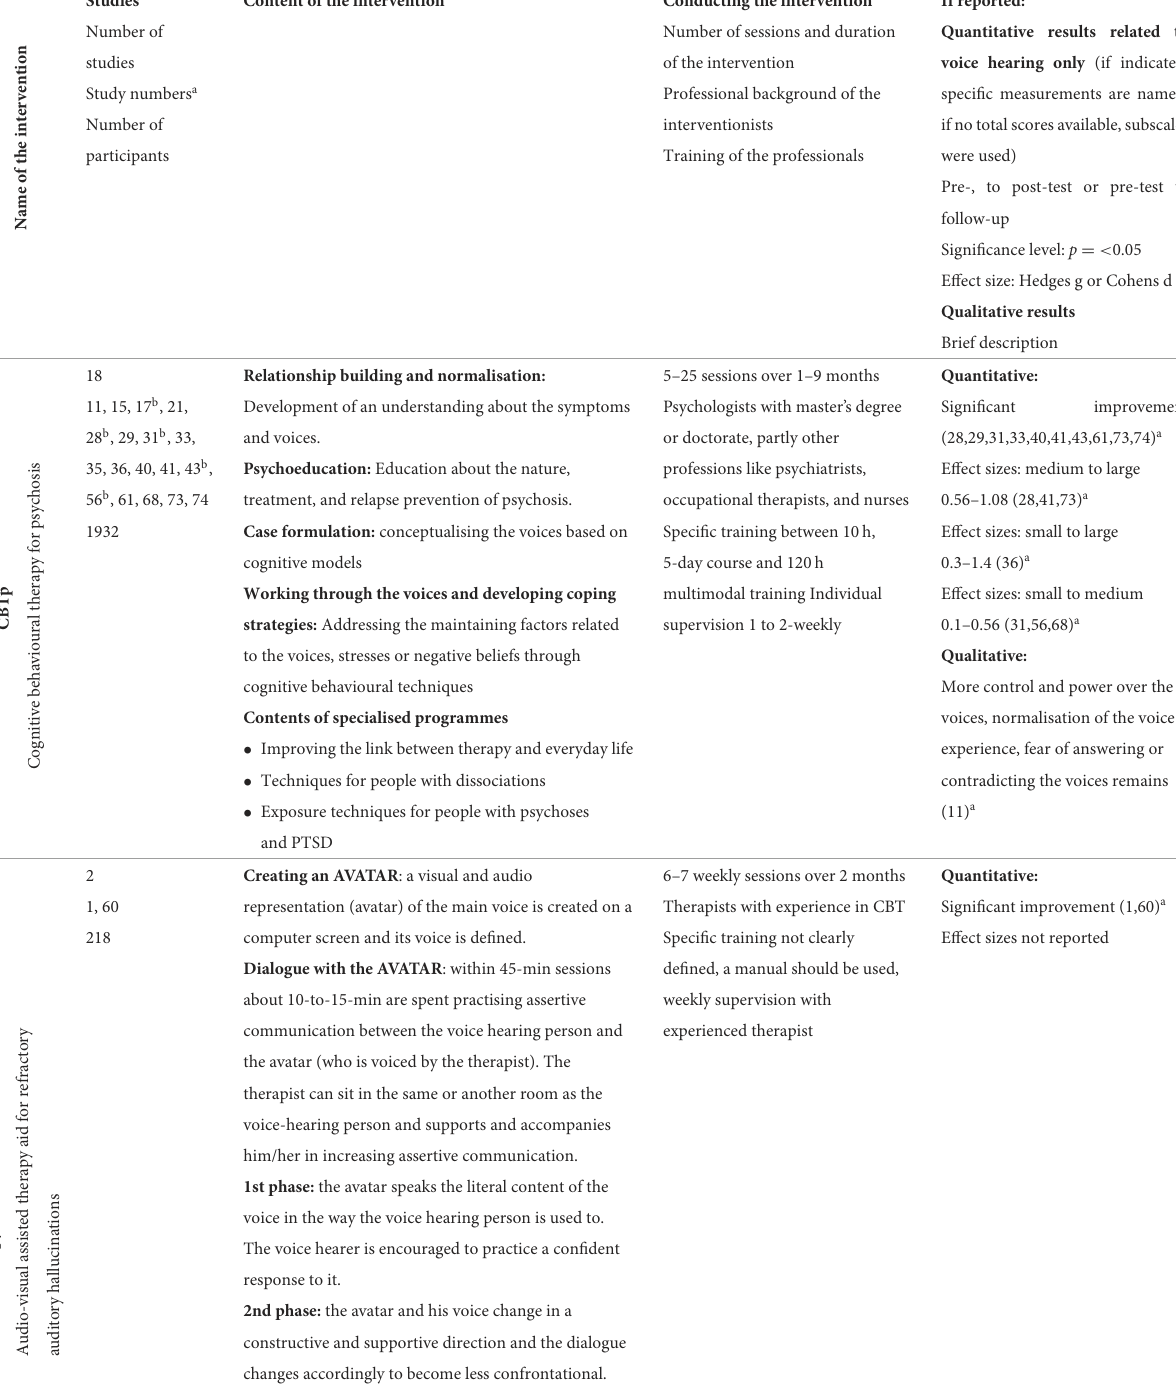
TABLE 3 Synthesis of studies of talk-based approaches with a primary focus on hearing